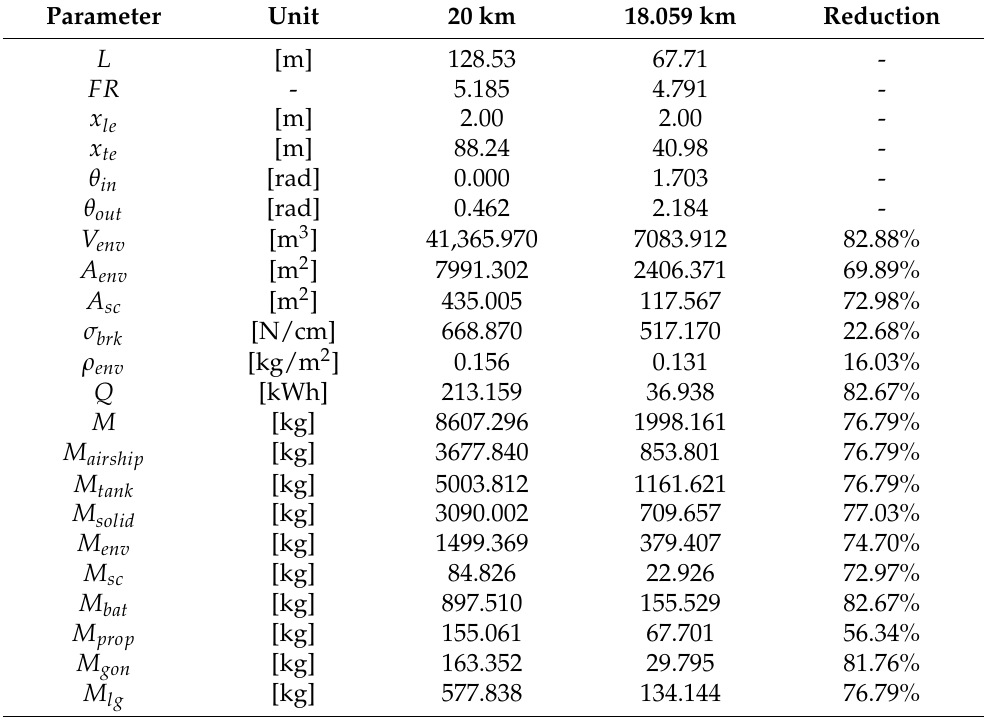
Table 11. Comparison between HAPS optimal designs for operation at 20 and 18.06 km altitudes above Port-au-Prince,